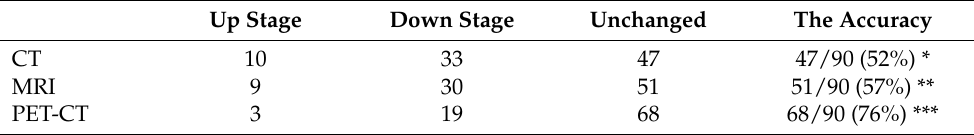
Table 4. Changed tumor staging assessed by CT, MRI, and PET-CT, respectively. Up Stage Down Stage Unchanged The Accuracy CT 10 33 47 47/90 (52%) *